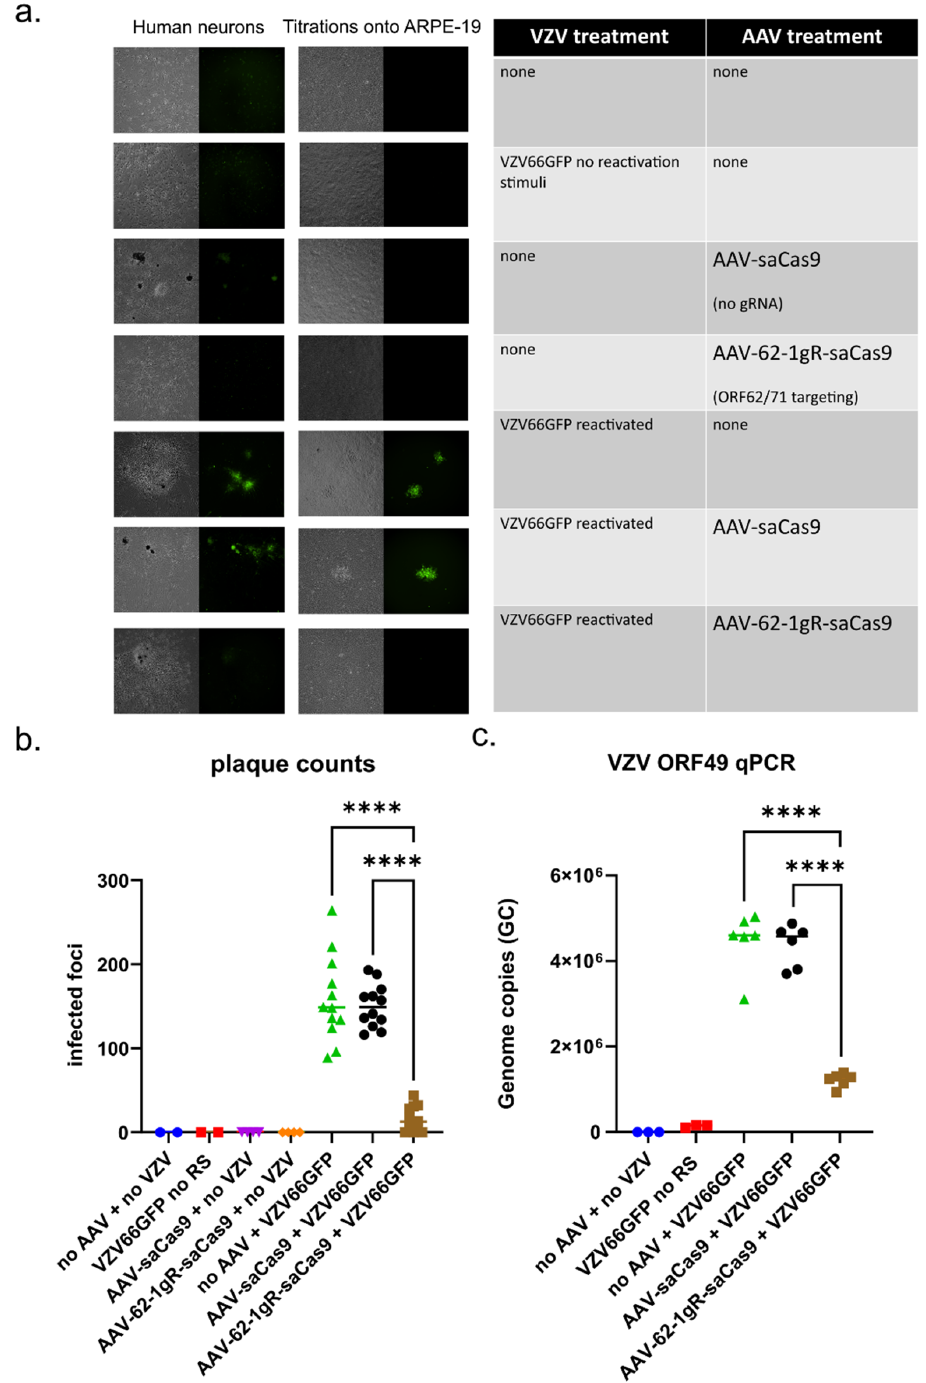
Figure 6. AAV-62-1gR-saCas9 treatment of latently infected neurons reduces VZV progeny and spread following reactivation induction. ( a ) hESC-derived neurons in 12-well plates were infected with 500 PFU of cell-free virus expressing GFP (VZV ORF66 GFP) in the presence of 50 μ M acyclovir (ACV) to establish latent infections. After 7 days in the presence of ACV, approximately 10 4 GC/cell of different AAV (or mock transduction) was added to the appropriate wells. ACV was then re- moved, and cultures incubated for a further 7 days. At 7-day post AAV transduction, GFP-negative neuron wells were left untreated or were stimulated to reactivate latent genomes by changing to